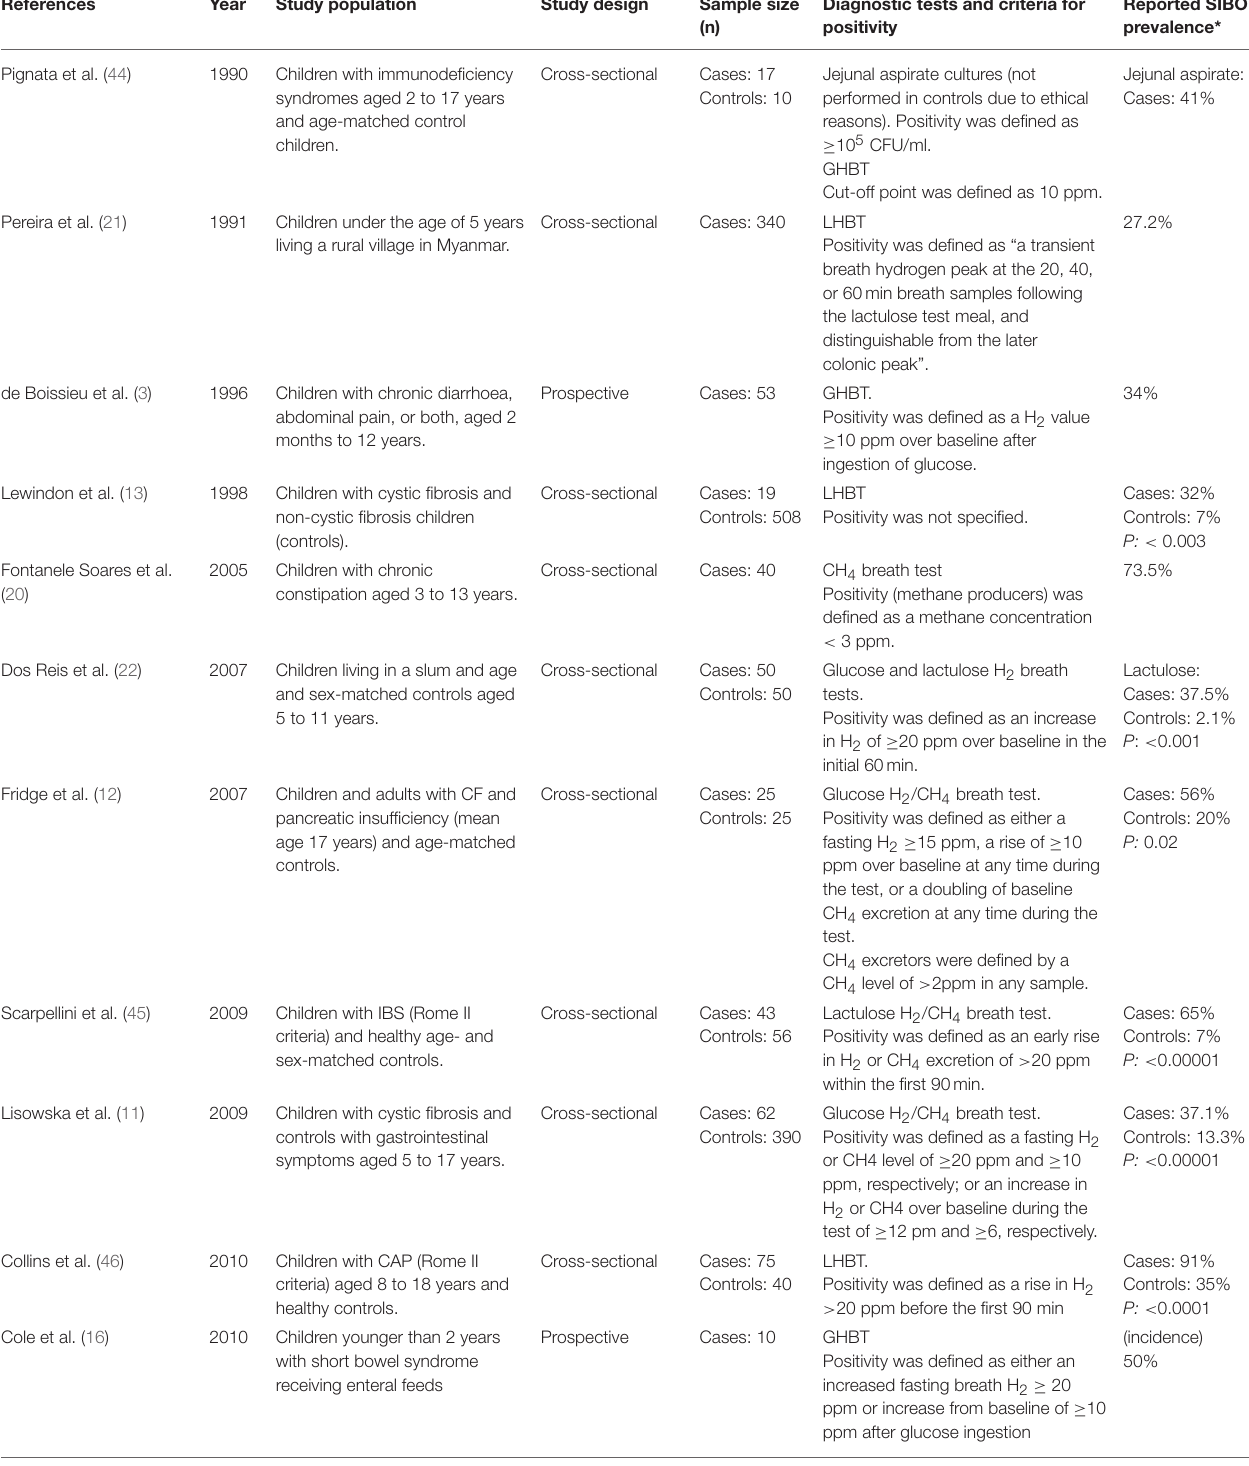
TABLE 1 | Study characteristics and reported SIBO prevalence in children with a wide variety of clinical contexts and risk